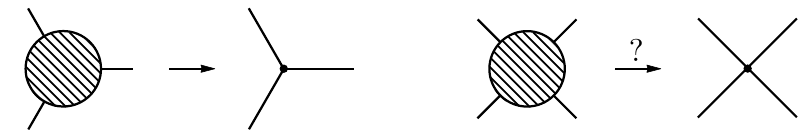
Figure 2 . Subparts of diagrams with loops and 3 external lines can be compressed into a 3-line vertex, reducing the number of loops of the diagram. For subparts with 4 external lines, this will only generate a renormalizable interaction if all external lines are